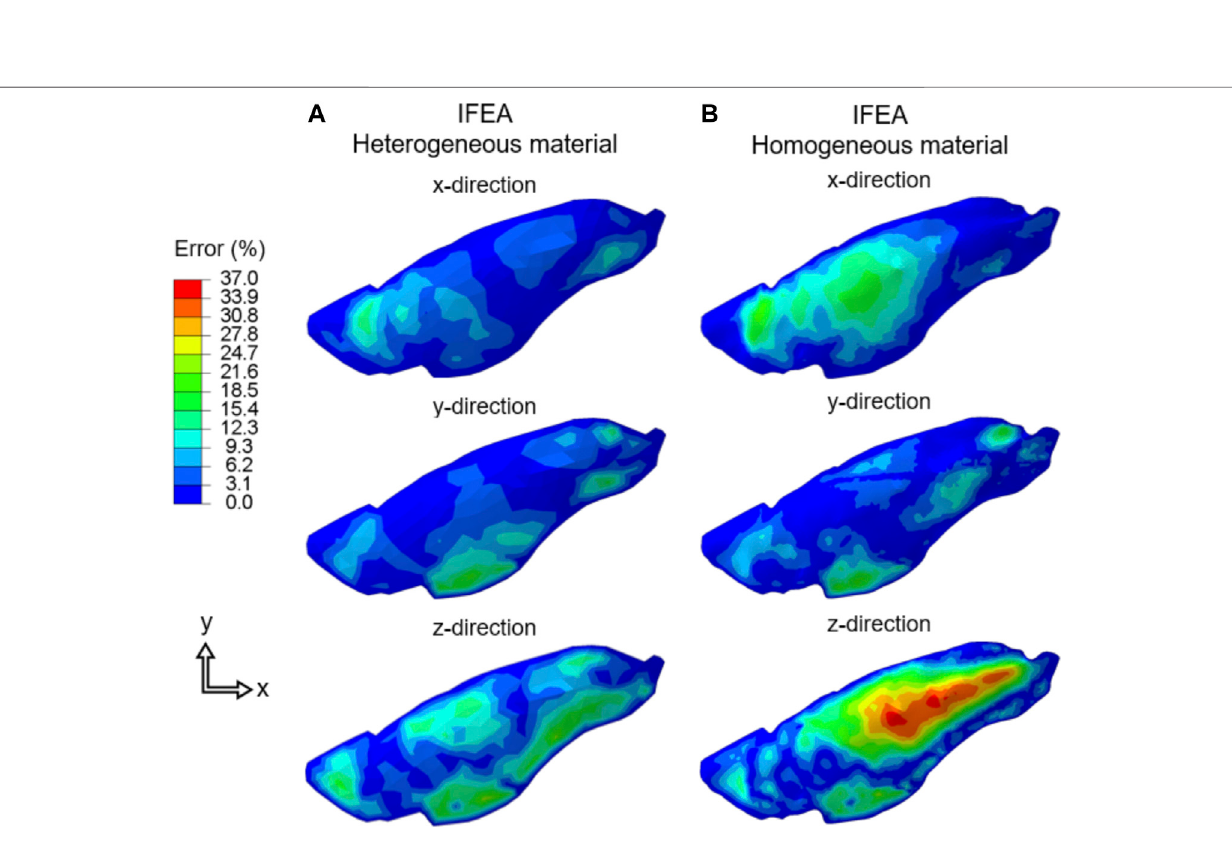
Frontiers in Bioengineering and Biotechnology |